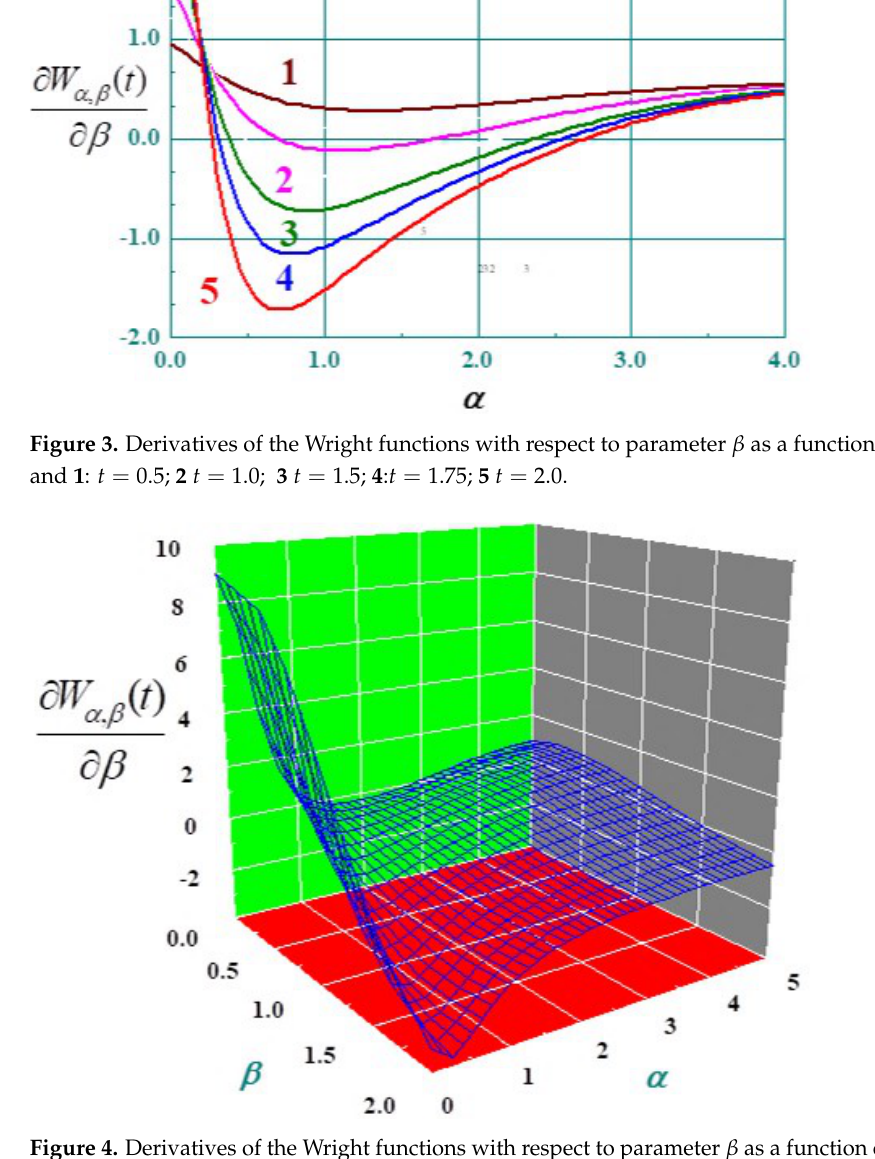
Figure 4. Derivatives of the Wright functions with respect to parameter β as a function of α and β = 1 for t =